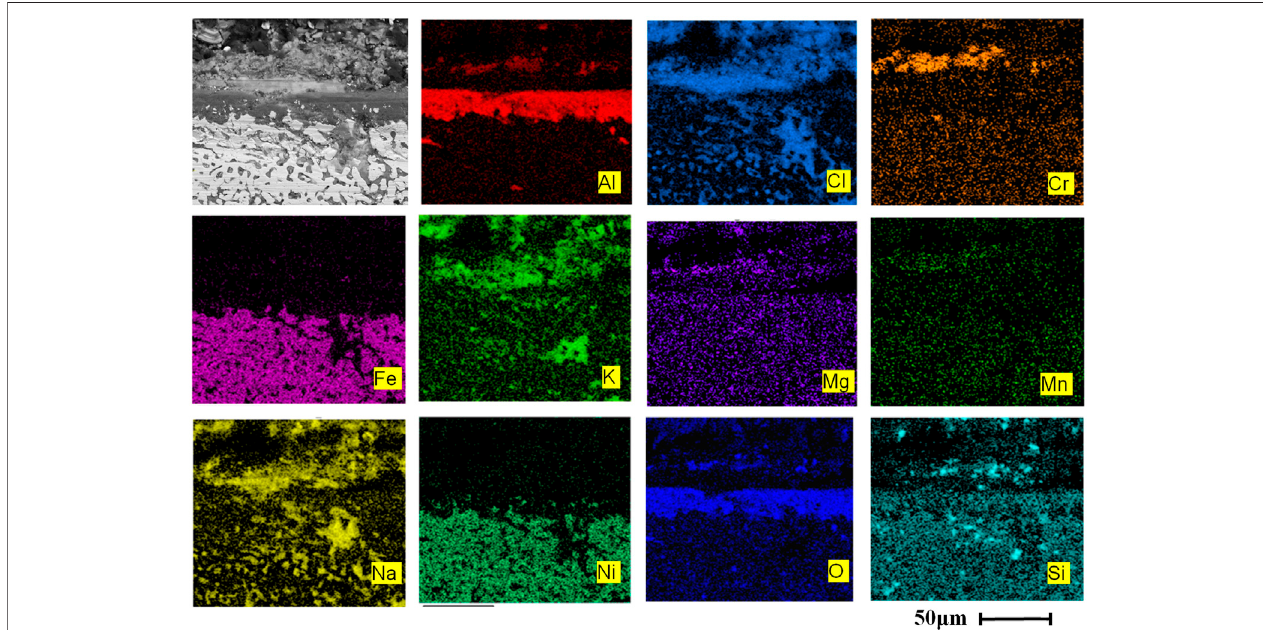
FIGURE 7 | EDS mapping of AFA 310S cross section for 120h at 800 ° C in chloride salt.